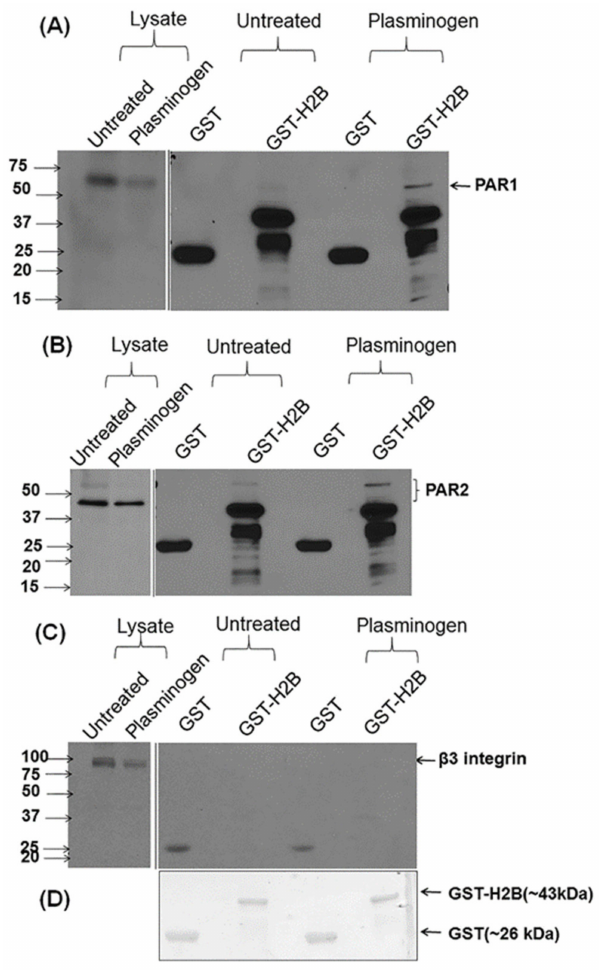
Figure 4. H2B associates with PARs and not with α v β 3, a transmembrane PlgR. GST-H2B pull-downs were performed on lysates of untreated (Ut) or Plg-stimulated HUVECs and probed by Western blots using mAbs to: ( A ) PAR1, ( B ) PAR2 and ( C ) the integrin β 3 subunit. GST alone was used as a loading control. ( D ) Equal loading of GST and GST-H2B is shown on Coomassie stained gels. Solid lines between gels denote the position of the molecular weight ladder, and the molecular weight markers, in kilodaltons, are indicated on each